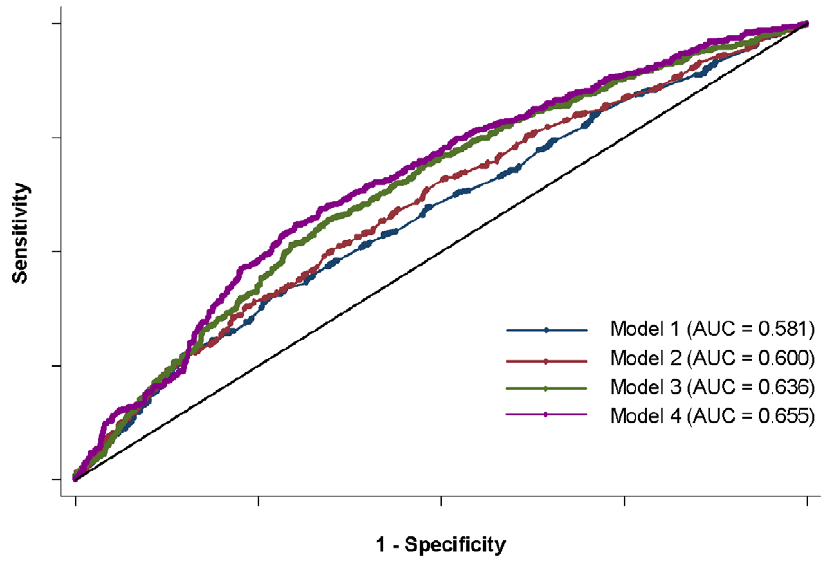
Figure 3. ROC curves for four anti–dsDNA models. Four models shown: 1) sex and disease duration alone, 2) adding top locus (STAT4) to first model, 3) adding GRS to first model, and 4) adding sub-GRS to first model.